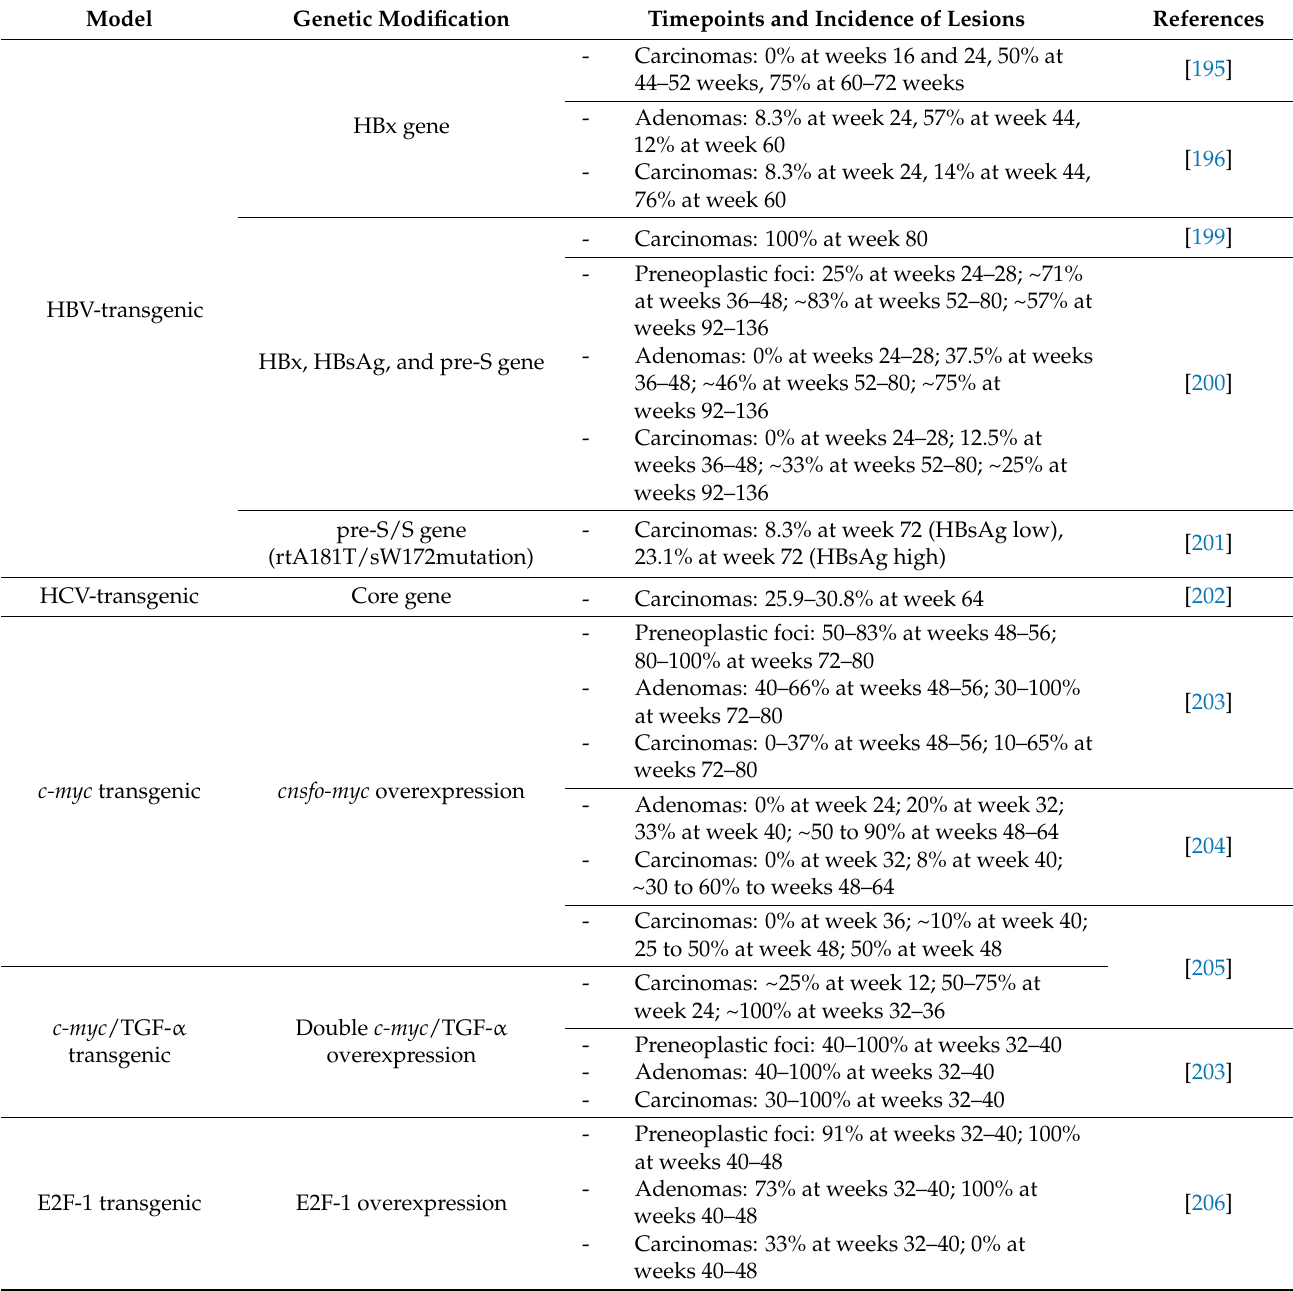
Table 5. Summary of some of the genetically-engineered models established in